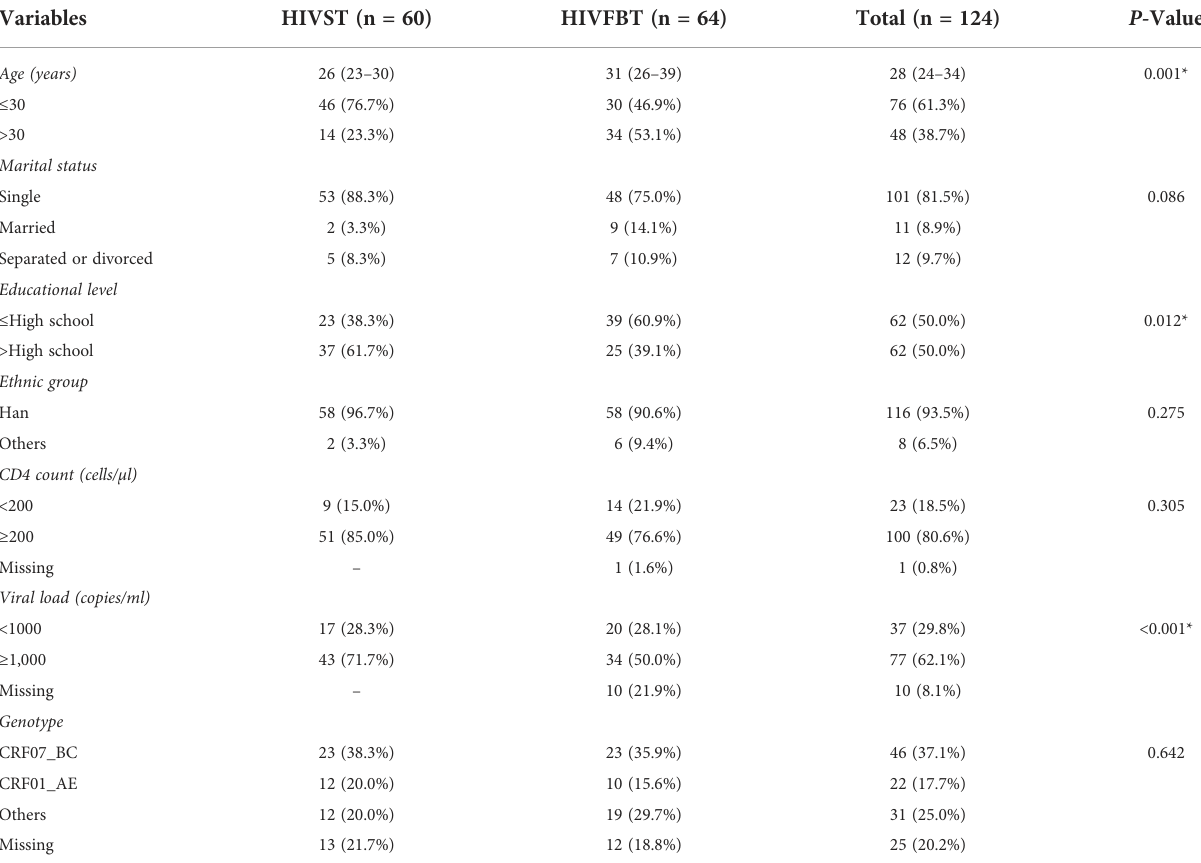
TABLE 1 Sociodemographic characteristics of MSM diagnosed as HIV positive in Zhuhai,